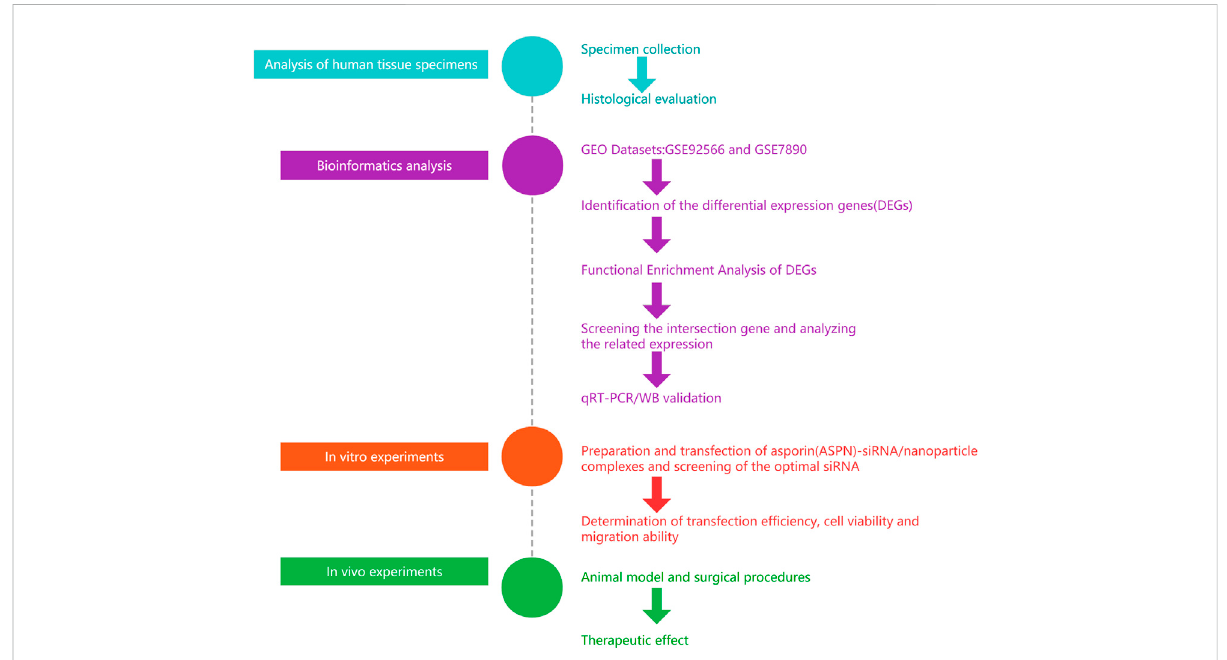
FIGURE 1 General fl owchart oftheexperiment. Weused bioinformaticanalysis to fi rst identify genes that were differentially expressedbetween diseased and normal skin. Then ASPN was con fi rmed as a crucial gene. The ideal ASPN-siRNA was then created and tested, and it was loaded onto PLGA nanoparticles for an in vitro investigation to evaluate its characteristics and transfection effectiveness. For in vivo research, we transplanted patient- provided keloid samples into nude mice. To assess the therapeutic effects after transplantation, we administered si-ASPN/nanoparticle complexes into the keloid